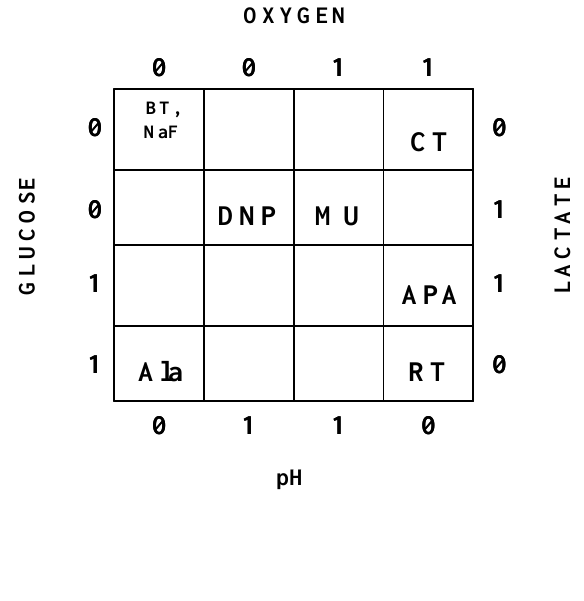
Figure 6. Binary four-by-four Karnaugh map of toxin responses. A '0' indicates a decrease and a '1' indicates an increase in the rate of consumption/production of analyte in response to the indicated analyte. BT = botulinum neurotoxin A, CT = cholera toxin, DNP = 2,4- dinitrophenol, MU = muscarine, APA = anthrax protective antigen, Ala = alamethicin, RT = ricin toxin, NaF = sodium fluoride. DNP, NaF from ref.